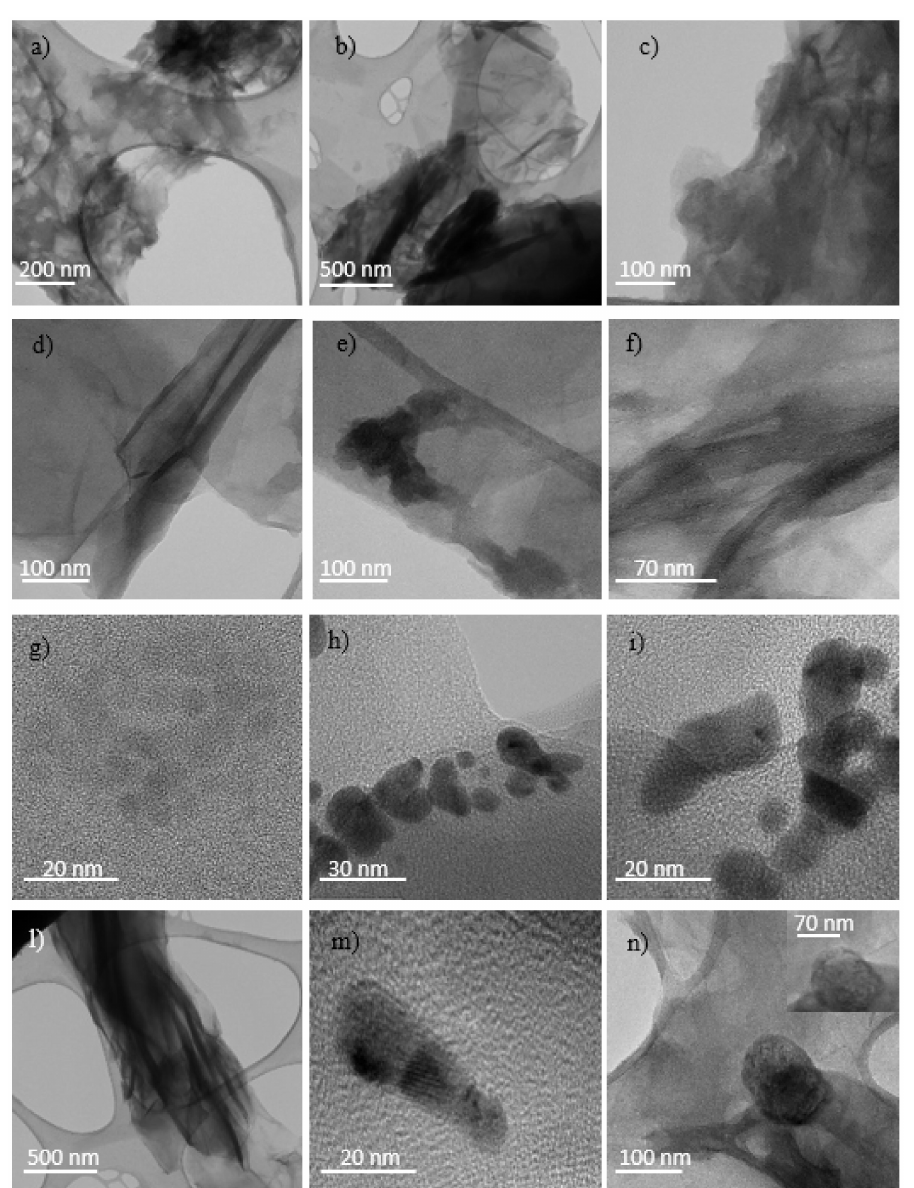
Figure 11. TEM micrograph of GO irradiated by the 3 MeV He + ions at the 5 × 10 11 ions/cm 2 ( a – c ), 5 × 10 12 ions/cm 2 ( d – f ), 5 × 10 13 ions/cm 2 ( g – i ) and 5 × 10 14 ions/cm 2 ( l – n )